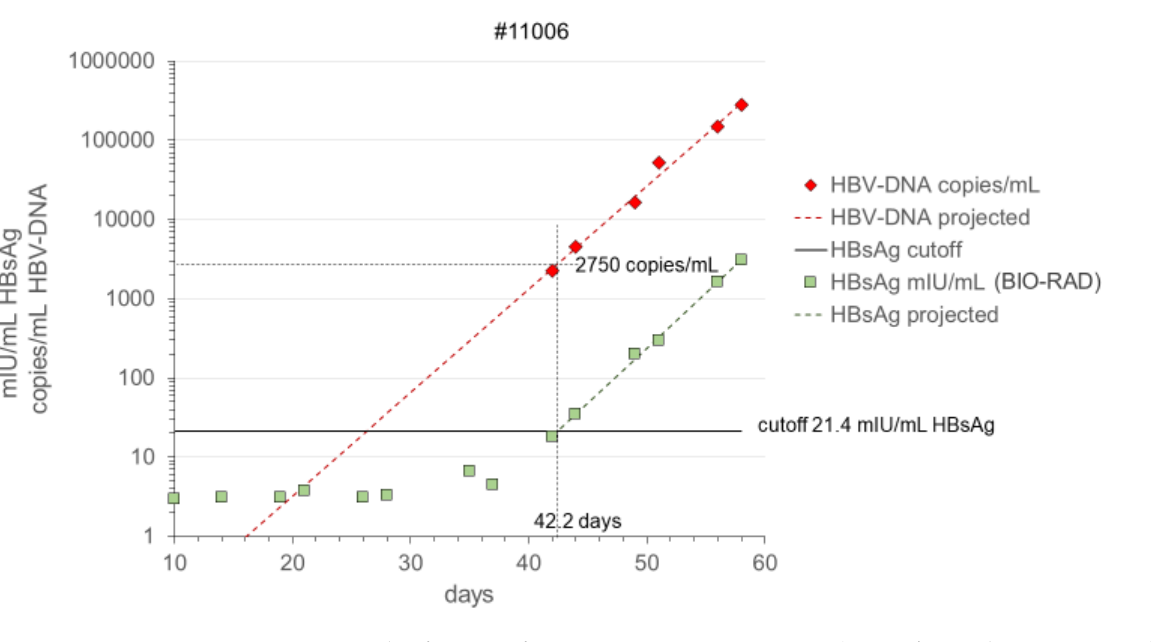
Figure 2. Example of course of Log HBV-DNA concentration (copies/mL in bDNA 3.0 assay) and Log HBsAg concentration (mIU/mL in BIO-RAD assay) in ramp-up phase of viremia (seroconversion panel #11006).